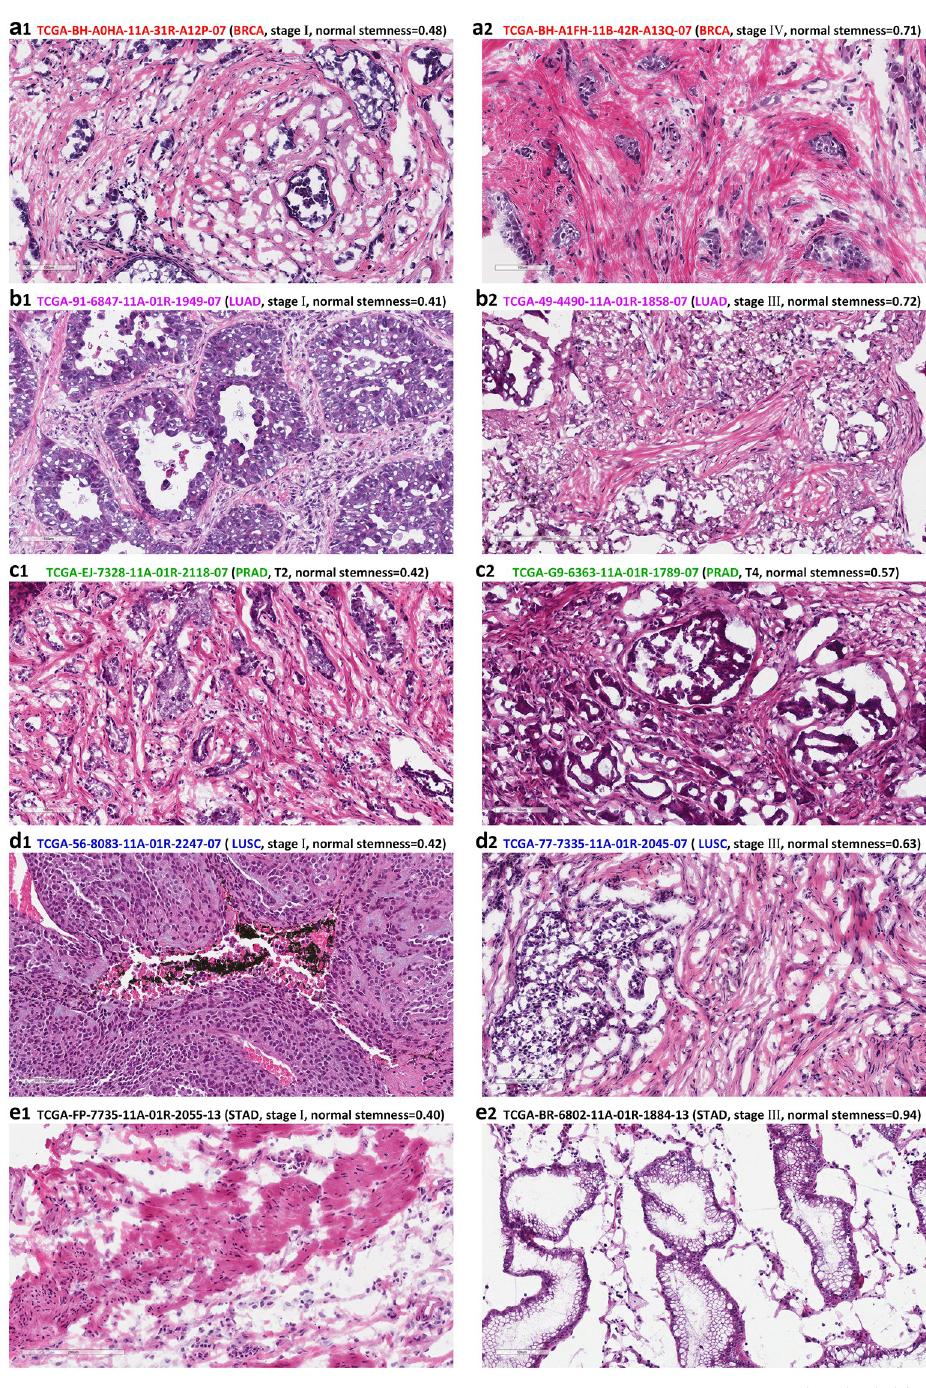
Fig 7. Pathological section of five tumor tissues with hematoxylin and eosin staining. Images are downloaded from the TCGA database (https://portal.gdc.cancer.gov/). IDs are taken from the lower left and upper right corners of Fig 6. The complete ID of the sample, tumor type, stage or T stage, and Normal stemness value are marked on the top of the picture. a1–a2 : BRCA (Breast invasive carcinoma); b1–b2 : LUAD (Lung adenocarcinoma); c1–c2 : PRAD (Prostate adenocarcinoma); d1–d2 : LUSC (Lung squamous cell carcinoma); e1–e2 : STAD (Stomach adenocarcinoma). The translucent scales are at the bottom left of each image (100 μ m or 200 μ m).